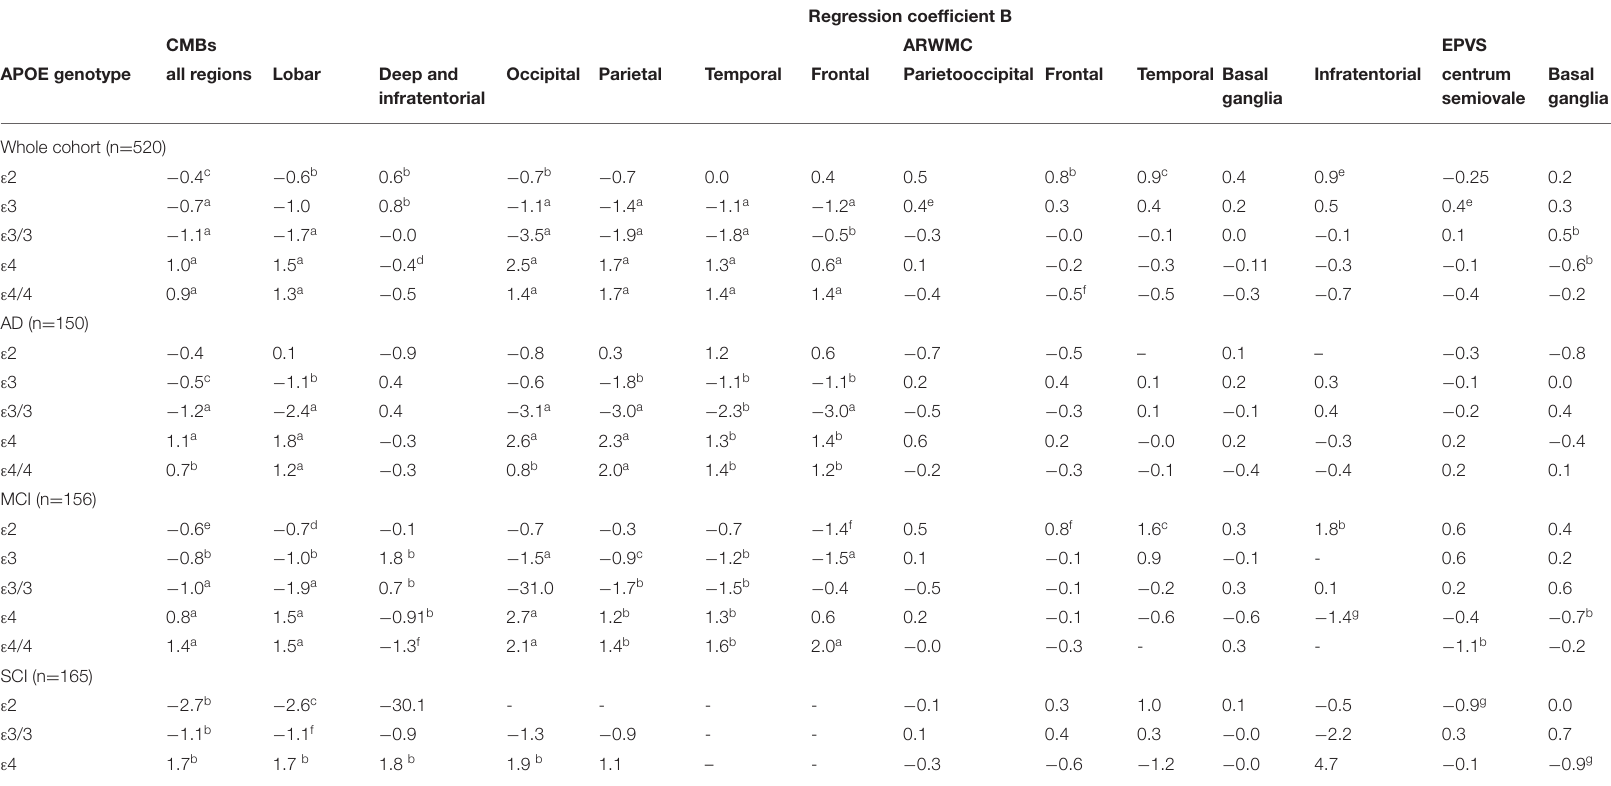
TABLE 3 | Regression coefficients for number/score of MRI markers by APOE